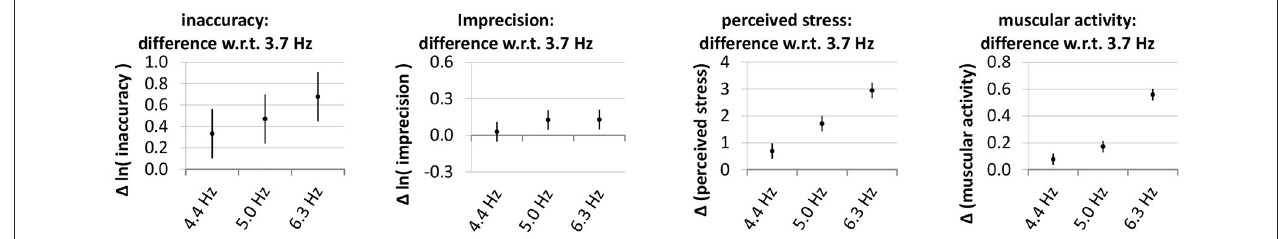
FIGURE 6 | Effect of the desired frequency on the outcome measures. The diagram shows the estimates and 95% confidence intervals of the differences between outcome measures at the higher desired frequencies and the outcome values at a frequency of 3.7Hz. Since the statistical model (Equation7) does not contain any interaction terms between frequency and expert status, the values are the same for experts and novices. Lower values are